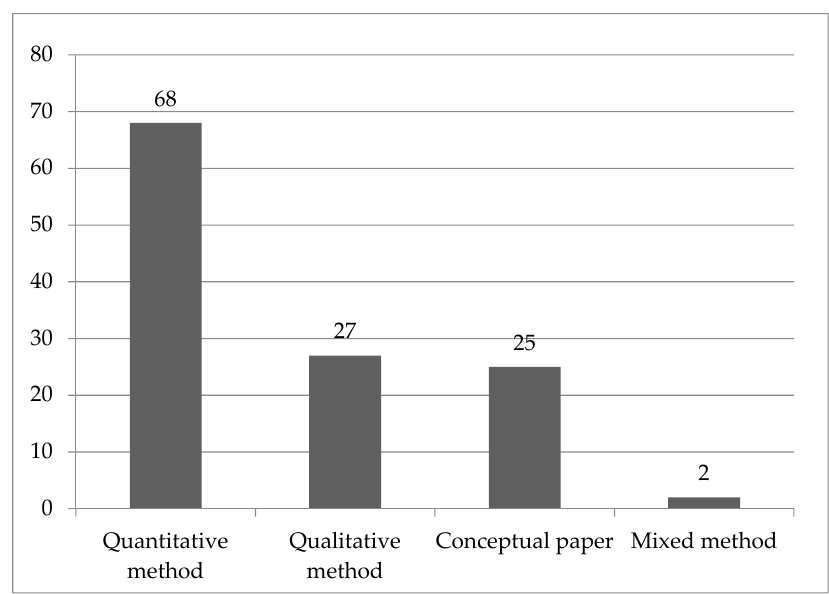
Figure 1. Papers by methodology.